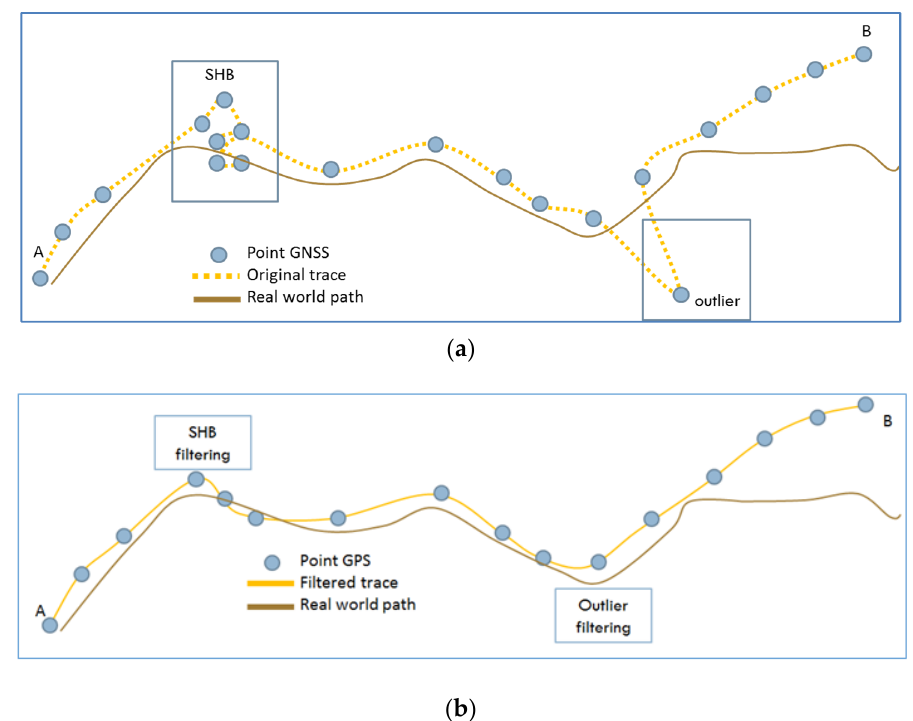
Figure 1. Example of a Global Navigation Satellite System (GNSS) trace following a path and making a picnic activity during the displacement from a point A to a point B: ( a ) Original trace; ( b ) expected result of our approach.